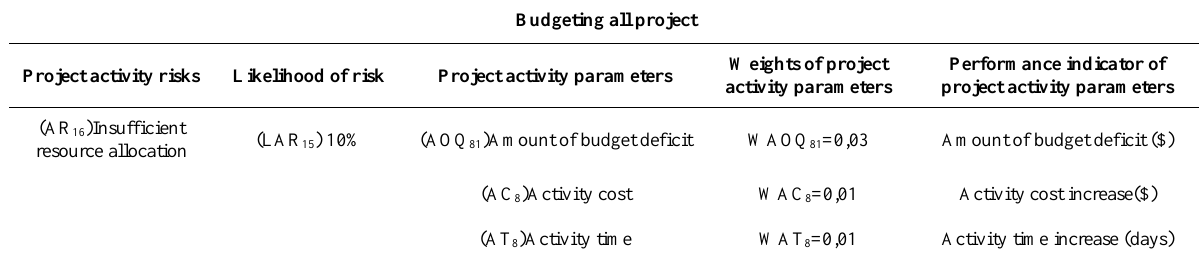
Table 9 . TOPSIS table information of budgeting all project.